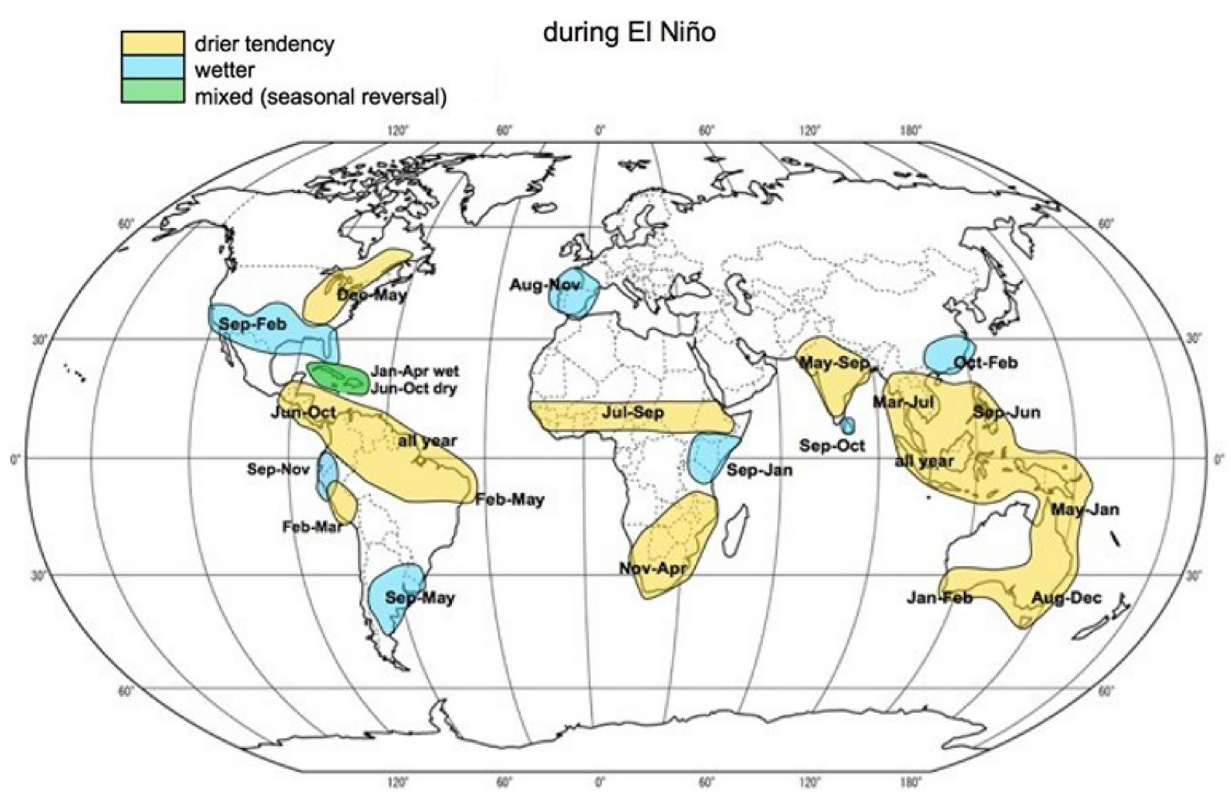
Fig. 5 This map identifies El Niño “hotspots” as well as the months (seasons) during which El Niño’s influence on societies and managed and unmanaged ecosystems are likely to be affected. Source UK Met Office (2019).